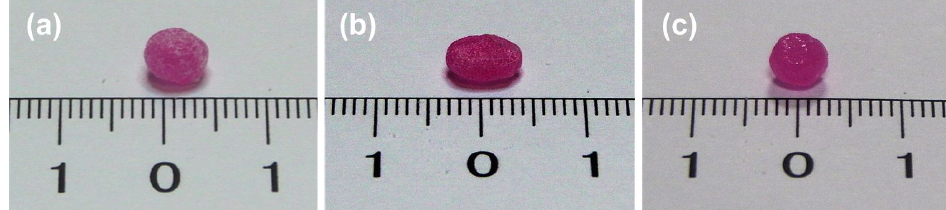
Figure 29. Thermo-responsive SME in PEG–hydrogel hybrid. ( a ) Original shape; ( b ) after programming; and ( c ) after heating for shape recovery. (Reproduced with permission from [104]. Copyright 2013